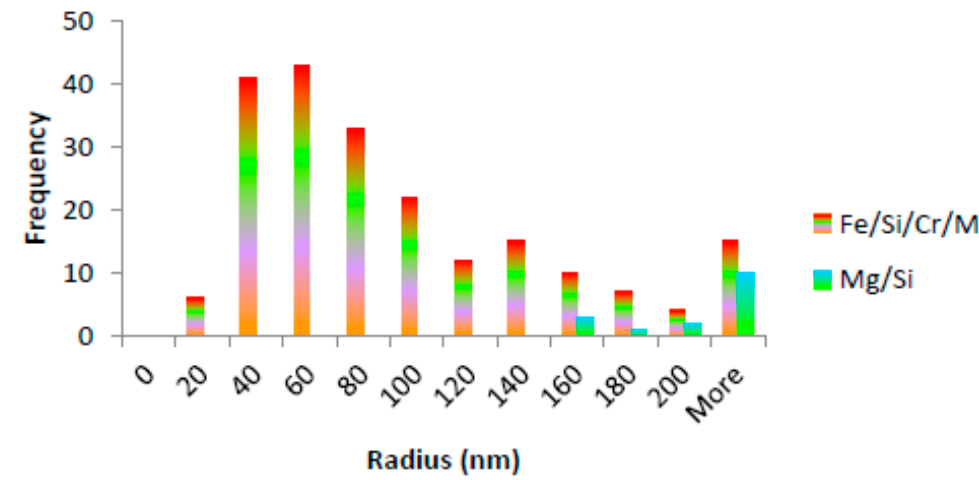
Figure 14. Precipitate radius size distribution of Al-Fe-Si-Cr-Mn and Mg-Si particles for heat-treated Al 6061 (540 °C for 1 h).